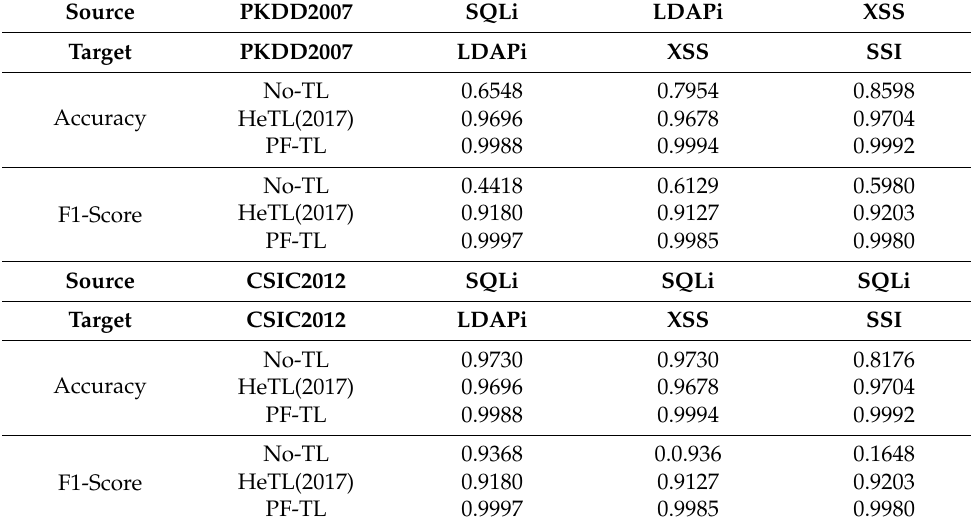
Table 8. Performance comparison of transfer learning on Scenario